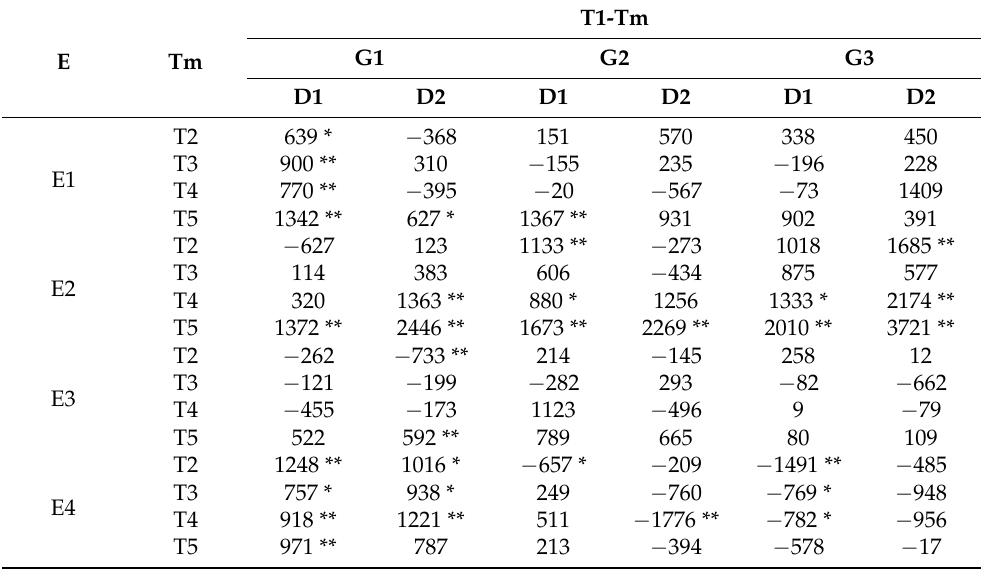
Table 10. Joint effect of genotype, year–location interaction and crop density on yield losses (kg/ha) in different defoliation